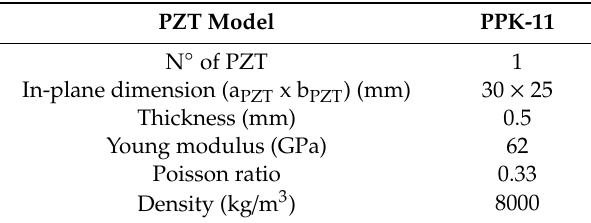
Table 5. PZT mechanical properties.